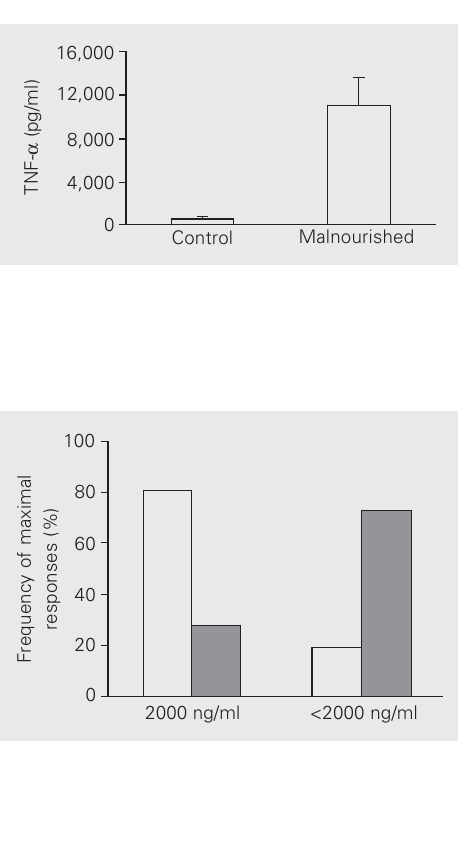
Figure 3. Ability of LPS to stimu- late tumor necrosis factor alpha (TNF- α ) production in 24-h whole blood cultures of indi- vidual subjects. Data are TNF- α levels in 24-h whole blood cul- tures of malnourished children (A, N = 11) and of healthy sub- jects (B, N = 18). Each line cor- responds to a subject whose production in the absence (left) and in the presence of optimal doses of LPS (right) is